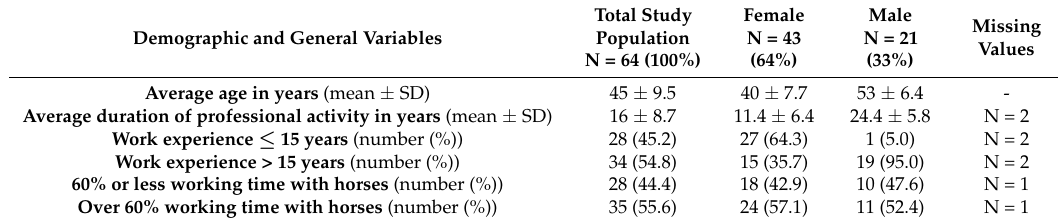
Table 1. Demographic and general variables (n = 64) presented for all survey respondents and separately for female and male